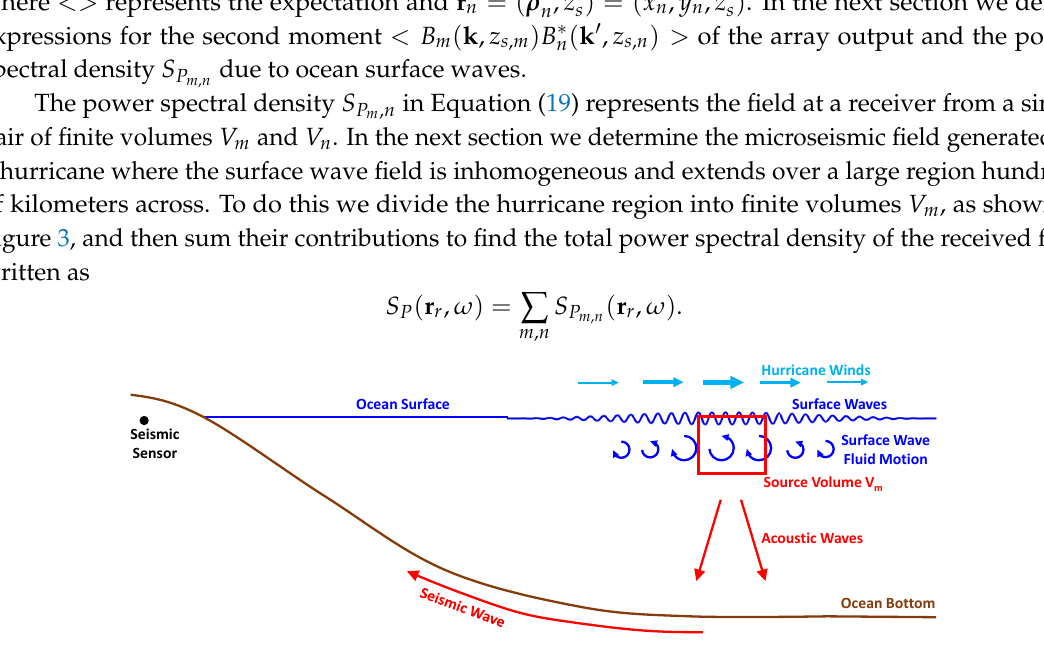
R and d are given in Table 1. The depth of the receiver below the ocean bottom of 162 m corresponds to the depth below the earth surface of the actual seismometer in Florida. The compression wave speeds c p are 1500 and 5200 m/s in the water and bottom respectively. The shear wave speed c s in the bottom is 3000 m/s. The densities ρ in the water and bottom are 1.0 and 2.5 g/cm